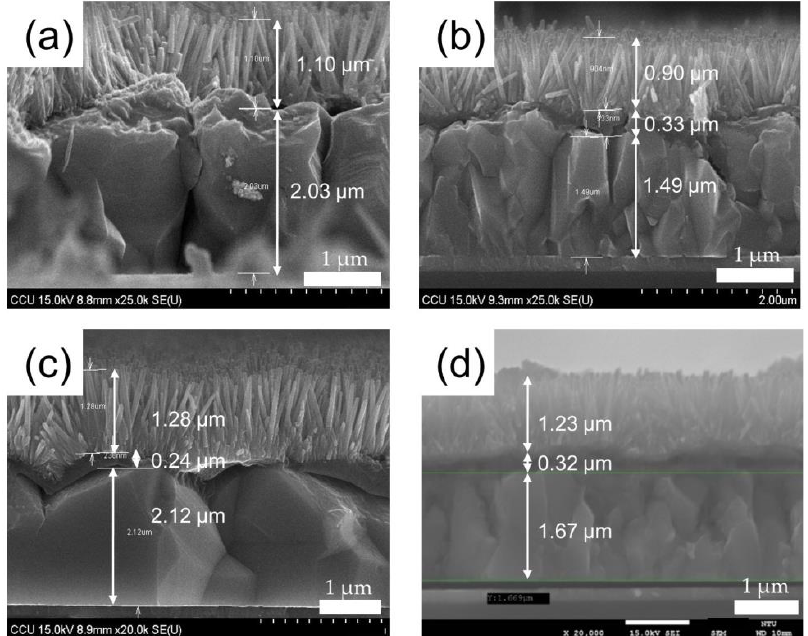
Figure 3. Cross-sectional SEM images of ( a ) Cu2O/ZnO NRs; ( b ) Cu2O/PEDOT:PSS/ZnO NRs; ( c ) Cu2O with hexamethylenetetramine (HMTA)/PEDOT:PSS/ZnO NRs; ( d ) Cu2O 25 min + Cu2O with HMTA 5 min/PEDOT:PSS/ZnO NRs heterostructure.